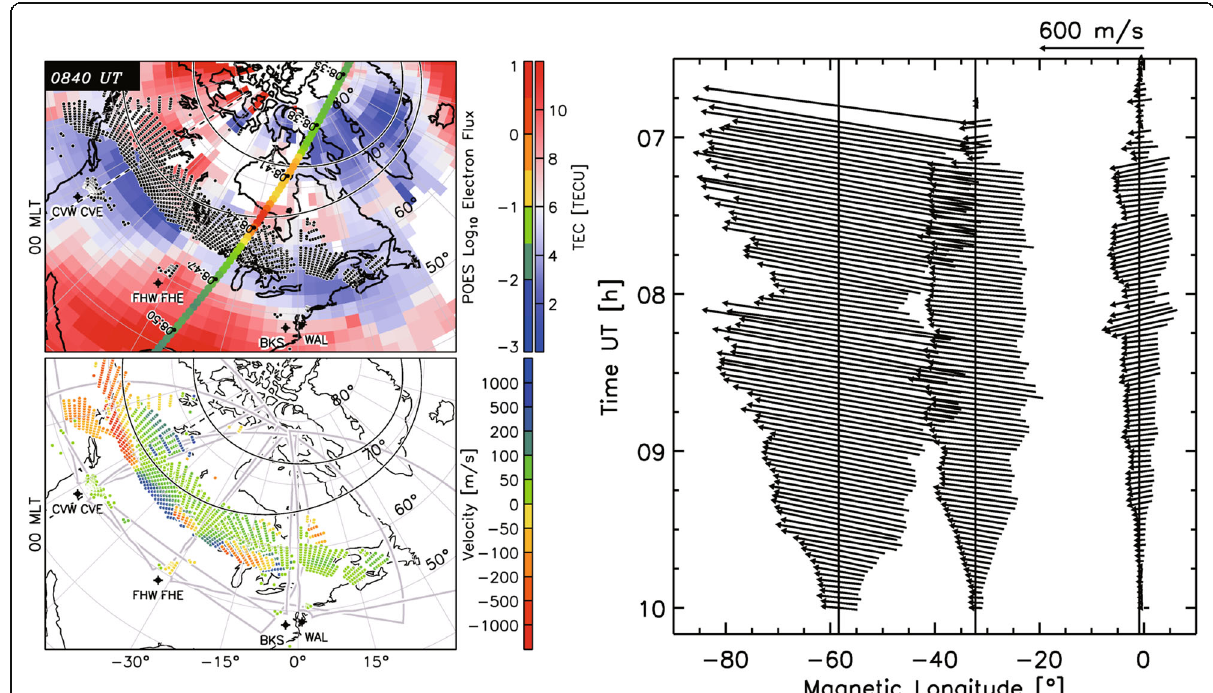
Fig. 12 Top/left: spatial distribution of GPS TEC with precipitating electron flux along a pass of NOAA/POES satellite. Bottom/left: 2-D map of LOS velocities observed by mid-latitude SuperDARN radars over North America at 0840 UT on 9 April 2011. Right: Vector representation of the average large-scale SAPS flow direction and the inferred SAPS speed identified by the three radar pairs. Time runs along the y axis, increasing toward the bottom. Adapted from Figs. 5 and 7 of Clausen et al.